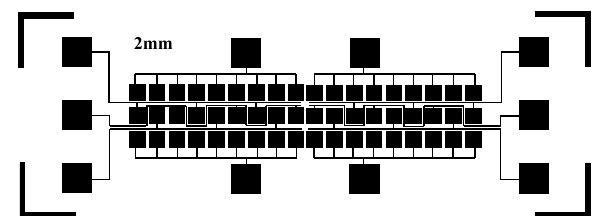
Figure 2. The electrode array of a digital microfluidics (DMF) chip, the size of a square electrode is 2 × 2 mm 2 , and the gap between two electrodes is 0.2 mm.